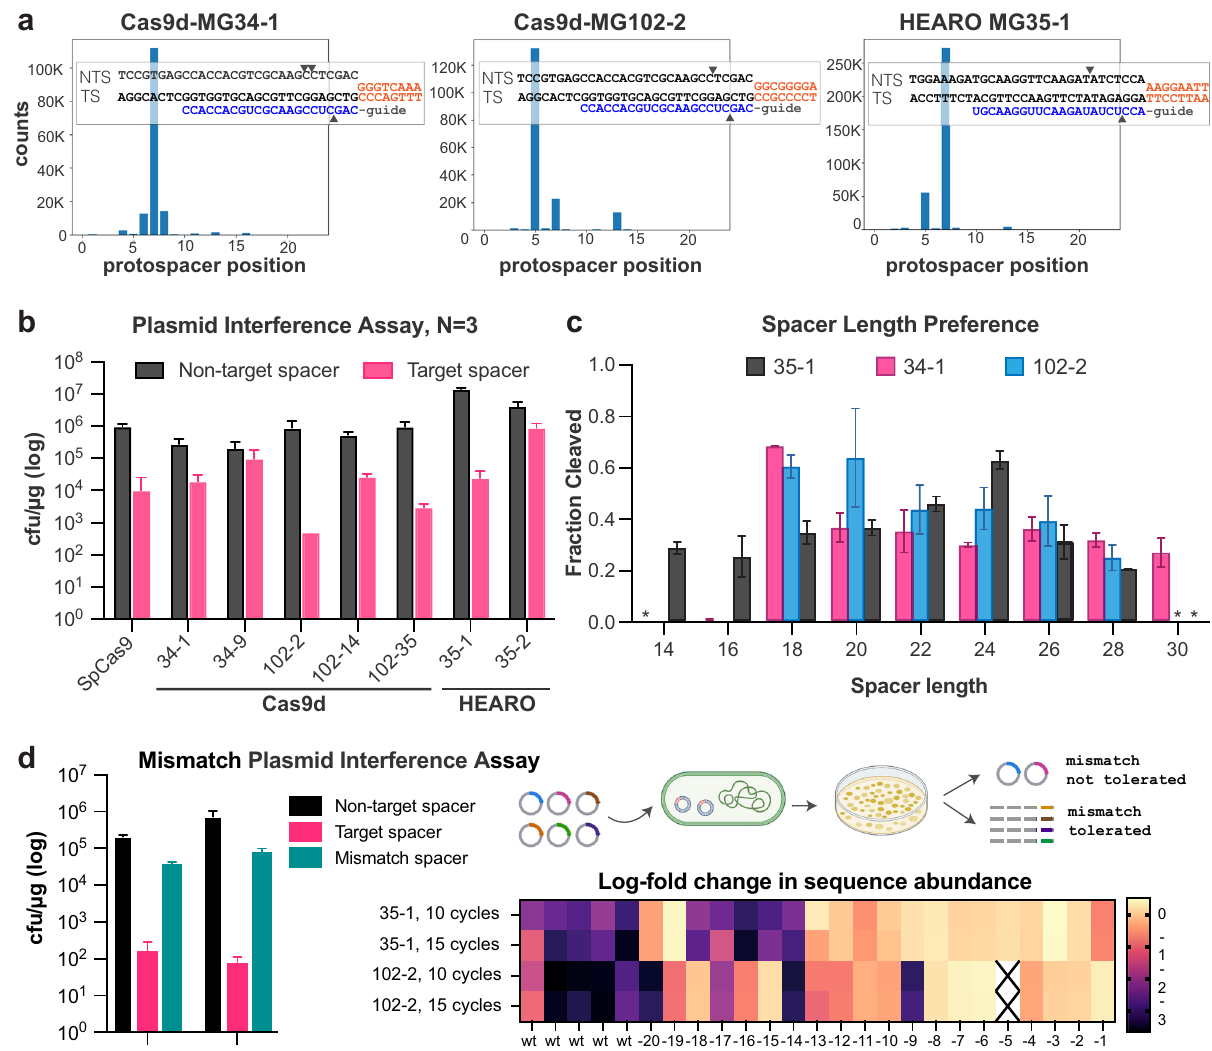
Fig. 2 | Cas9d and HEARO enzymes are dsDNA nucleases. a Histograms of clea- vage position preference for three active nucleases on the non-target strand from NGS. The insets show a staggered cut, where cleavage at position 3 occurs on the targetstrand(TS),whilecleavageatpositions5 – 7fromthePAMoccursonthenon- target strand (NTS). The TS cleavage site was determined via Sanger run-off sequencing. b Bar plot of colony forming unit (cfu) measurements (in log-scale) showing E. coli growth repression in the target condition vs. the non-target con- trols. Plasmid interference assays for each nuclease were done in triplicate along with the SpCas9 positive control. Whiskers represent the standard deviation from the mean. c Measurement of in vitro DNA cleavage ef fi ciency with varying spacer lengths indicates a preference for 18 – 20bp spacers for Cas9d nucleases, while the HEAROnuclease MG35-1 prefers24bp spacers. (*)spacerlengths 14bp(for Cas9d- MG34-1), and 30bp (for HEARO MG35-1 and Cas9d-MG102-2) were not evaluated. Whiskers represent the standard deviation from the mean. d Mismatch plasmid